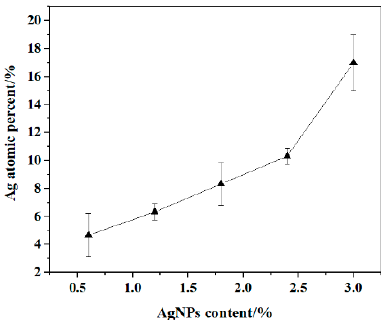
Figure 6. EDX measured variation curve of Ag relative atomic percentage on the surface part of the nanofibers with different AgNPs content.